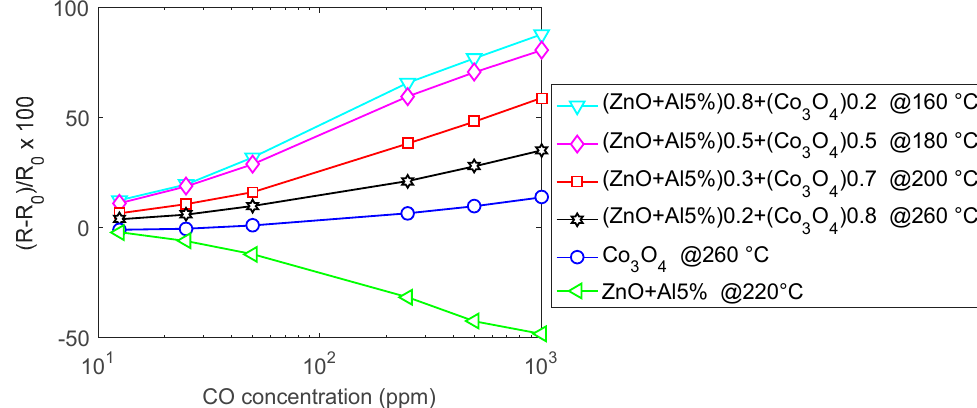
Figure 13. Response to CO as a function of CO concentration (dry environment).